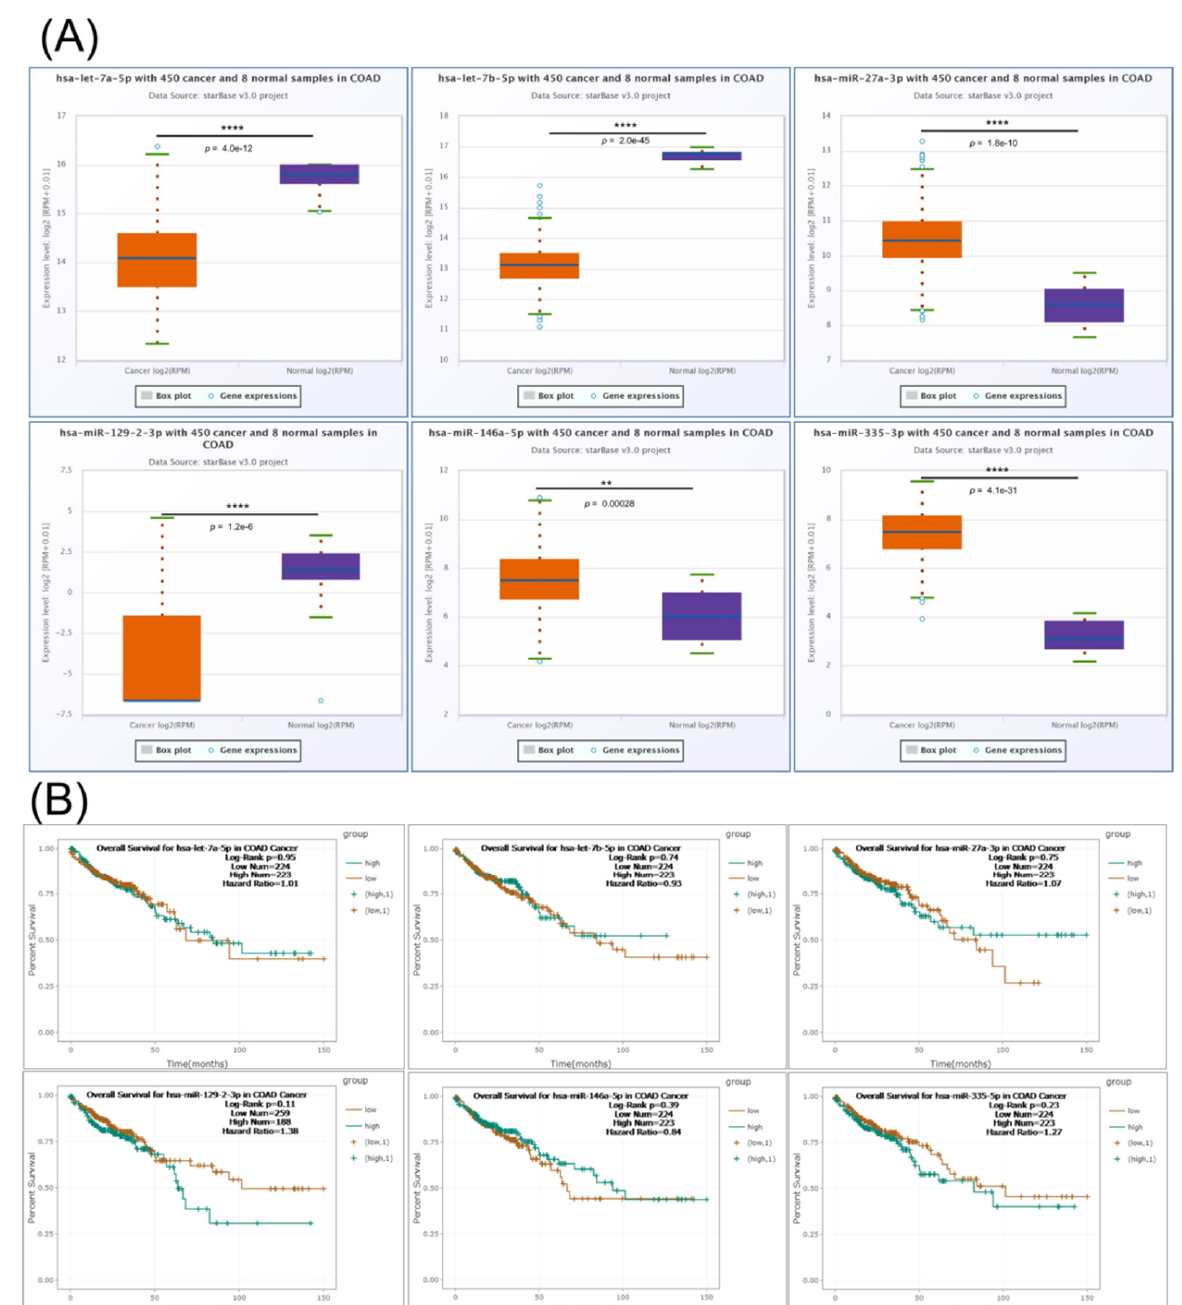
Figure 6. The expression level and survival analysis of miRNAs targeting key EMT genes in COAD with StarBase. ( A ) Expression levels in COAD of let-7a-5p, let-7b-5p, miR-27a-3p, miR-129-2-3p, miR-146a-5p and miR-335-3p based on StarBase; ( B ) Kaplan–Mayer plot in COAD for let-7a-5p, let-7b-5p, miR-27a-3p, miR-129-2-3p, miR-146a-5p and miR-335-3p based on StarBase. ns p > 0.05; ** p ≤ 0.01; **** p ≤ 0.0001